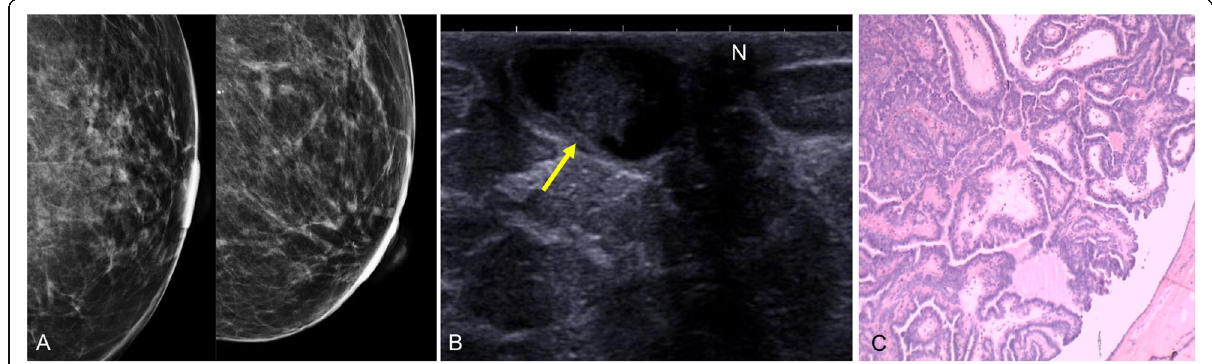
Fig. 24 Solitary intraductal papilloma. A 68-year-old woman with a palpable retroareolar nodule in her left breast. a Normal findings on craniocaudal and mediolateral oblique 2D mammograms. b Ultrasound shows a cystic lesion with a solid nodule inside it (arrow) adjacent to the nipple (N). c Hematoxylin-eosin stain (×4) shows branching intraductal structures consisting of a central fibrovascular axis surrounded by epithelial and myoepithelial